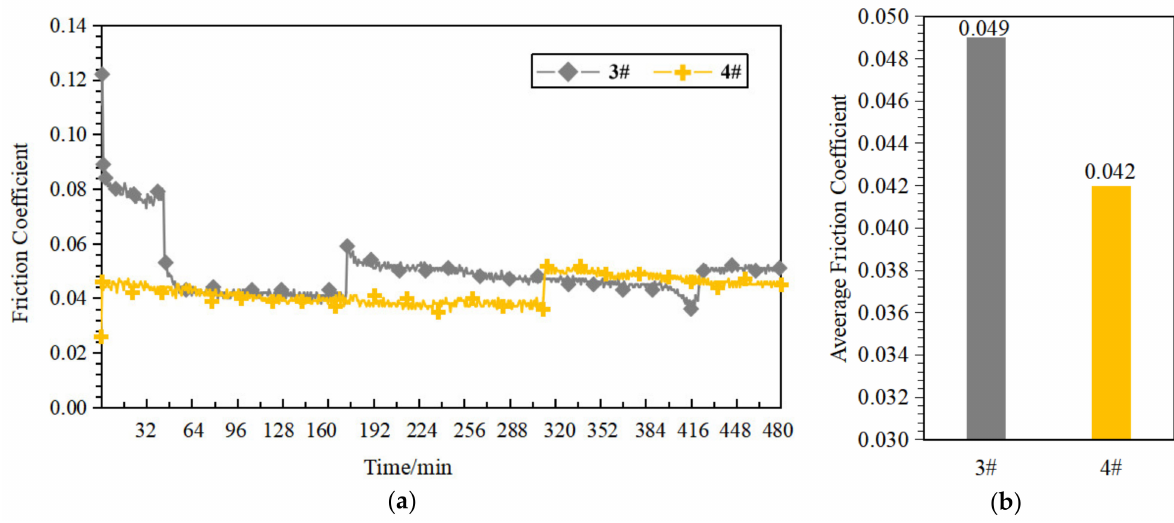
Figure 13. Long-term tribological performance of samples 3# and 4#. ( a ) Friction coefficient curve; ( b ) Average friction